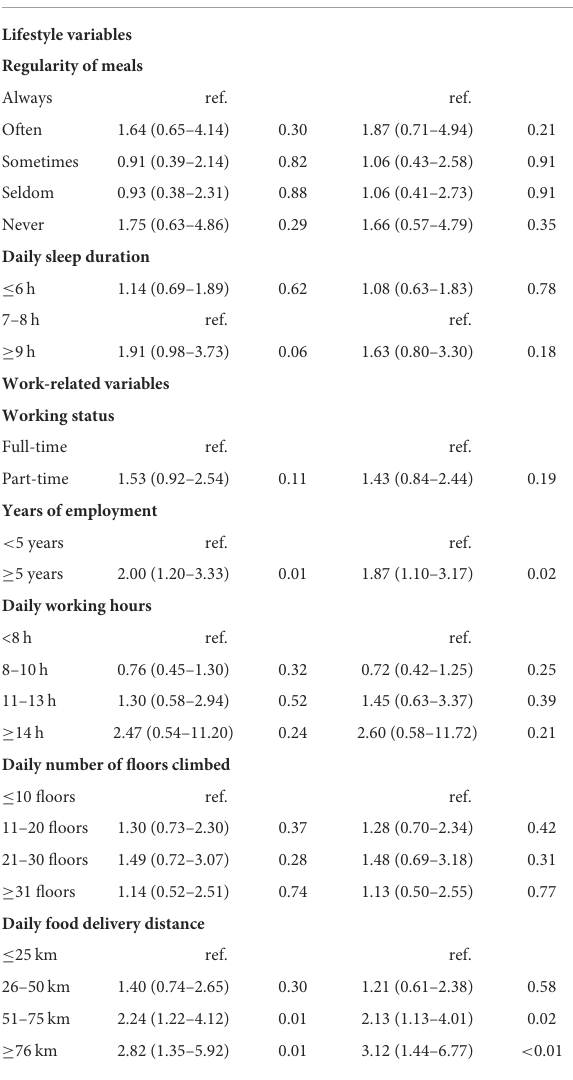
TABLE 3 Possible influencing factors of the severity of MSDs symptoms.